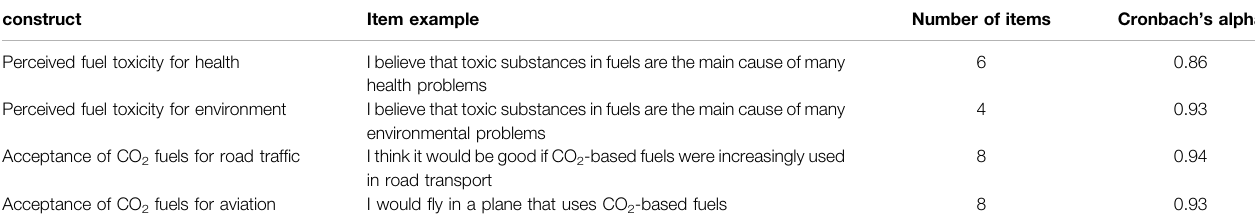
TABLE 1 | Item analysis for scales used in the study.